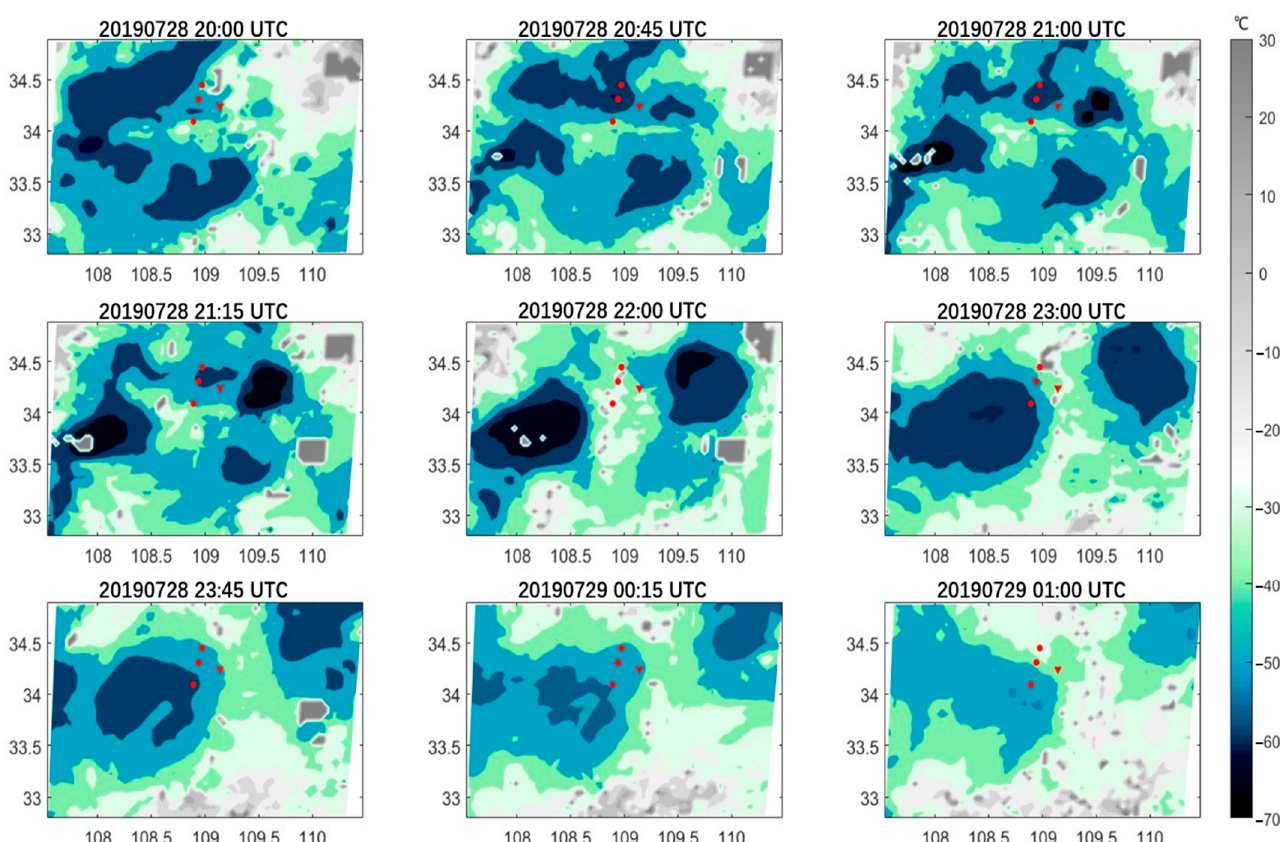
Figure 1. Variation characteristics of cloud top temperature with time from FY-4A satellite observa- tions of hail processes. The red triangle marks the location of the hailfall (Lintong station), and the red dots mark the location of the ground-based microwave radiometer, corresponding from north to south to the Gaoling, Weiyang, and Chang’an districts.